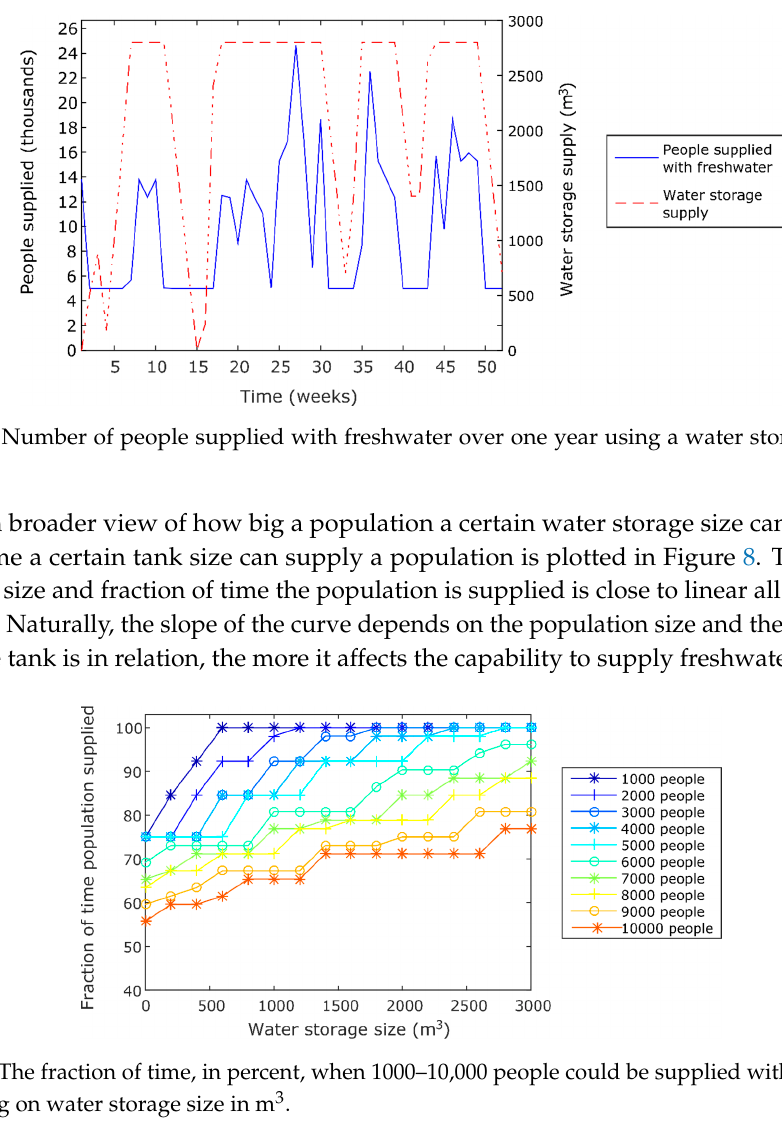
Figure 8. The fraction of time, in percent, when 1000–10,000 people could be supplied with freshwater depending on water storage size in m 3 .